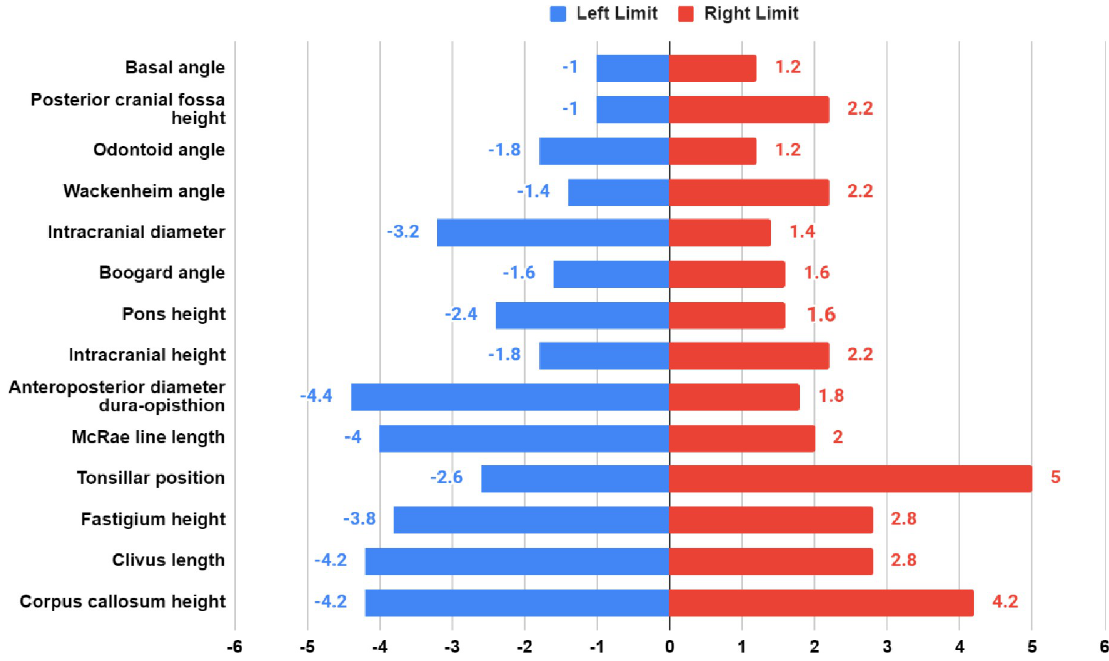
Fig 4. The average lateral distance from midsagittal plane (mm) at which the parasagittal error (difference between morphometric measurement at the parasagittal and midsagittal planes) exceeds 1 unit (mm/deg).